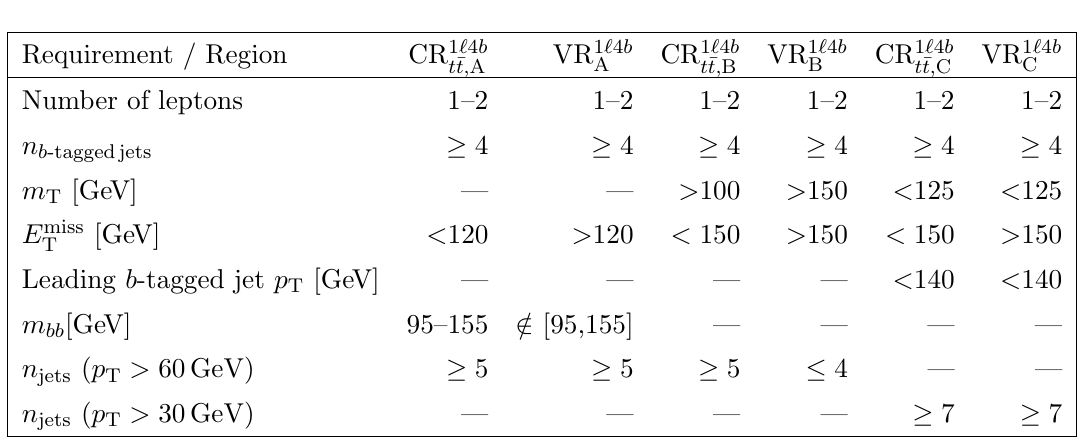
Table 6. Summary of selection criteria for the control and validation regions in the 1 ‘ 4 b selection.